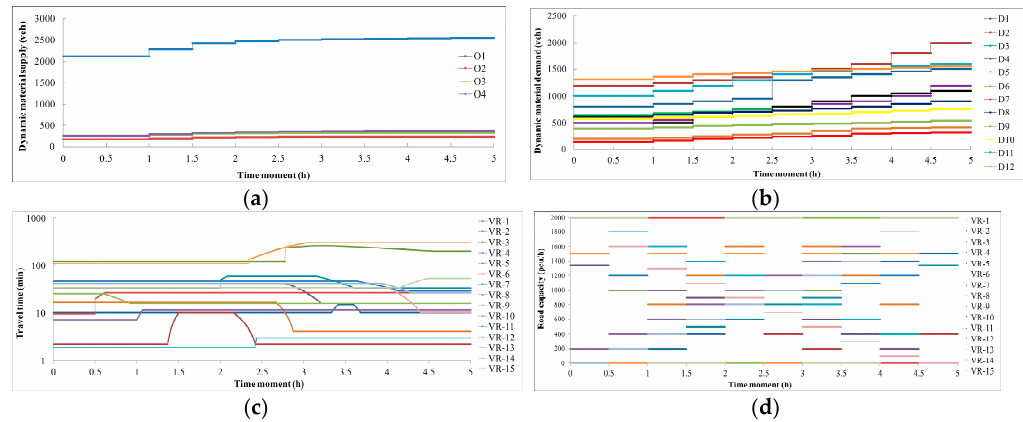
Figure 7. The dynamic environment variable: ( a ) the dynamic emergency material supply of emergency material depositories without exportation; ( b ) the dynamic limited emergency material demands of disaster points without importation; ( c ) the dynamic travel times of vulnerable roads; ( d ) the dynamic capacity of vulnerable roads, where “pcu” means “passenger car unit” and “pcu/h” refers to the number of vehicles passing through road per hour.